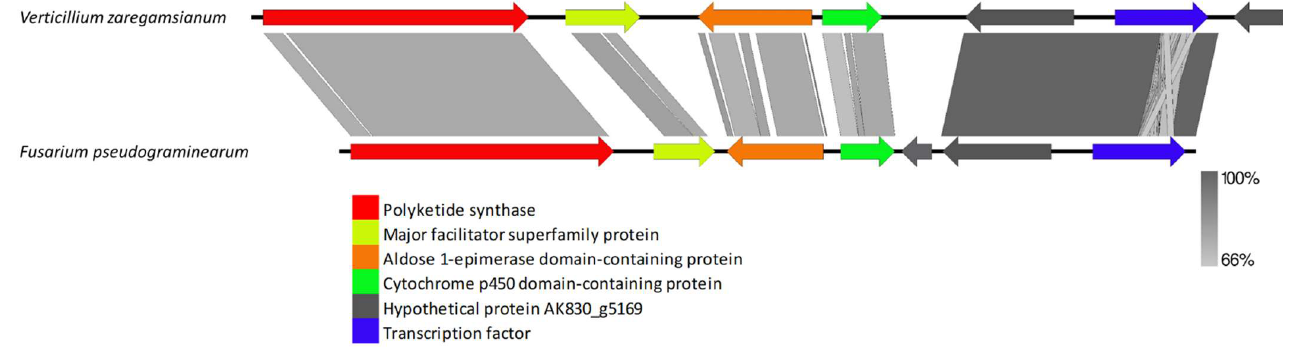
Figure 11. Comparison of putative cluster genes for Verticillium zaregamsianum VRPKS-I-7 cluster and fusarielin biosynthesis gene cluster from Fusarium pseudograminearum . The arrowheads indicate the direction of transcription and the types of genes common to the two clusters being compared are displayed in the same color. Shaded lines represent similarities between nucleotide sequences.